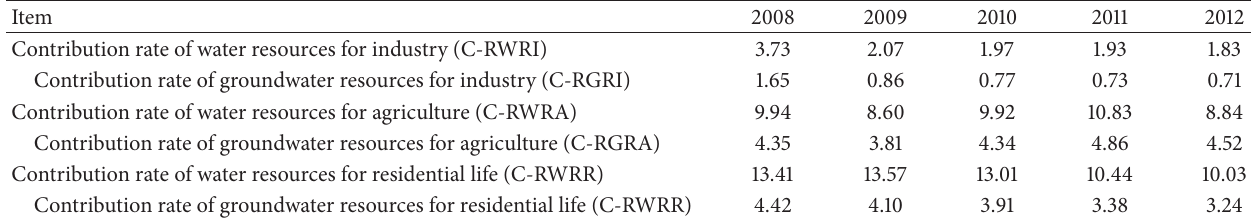
Table 7: The Summary table of contribution rate of water resources (unit: %).